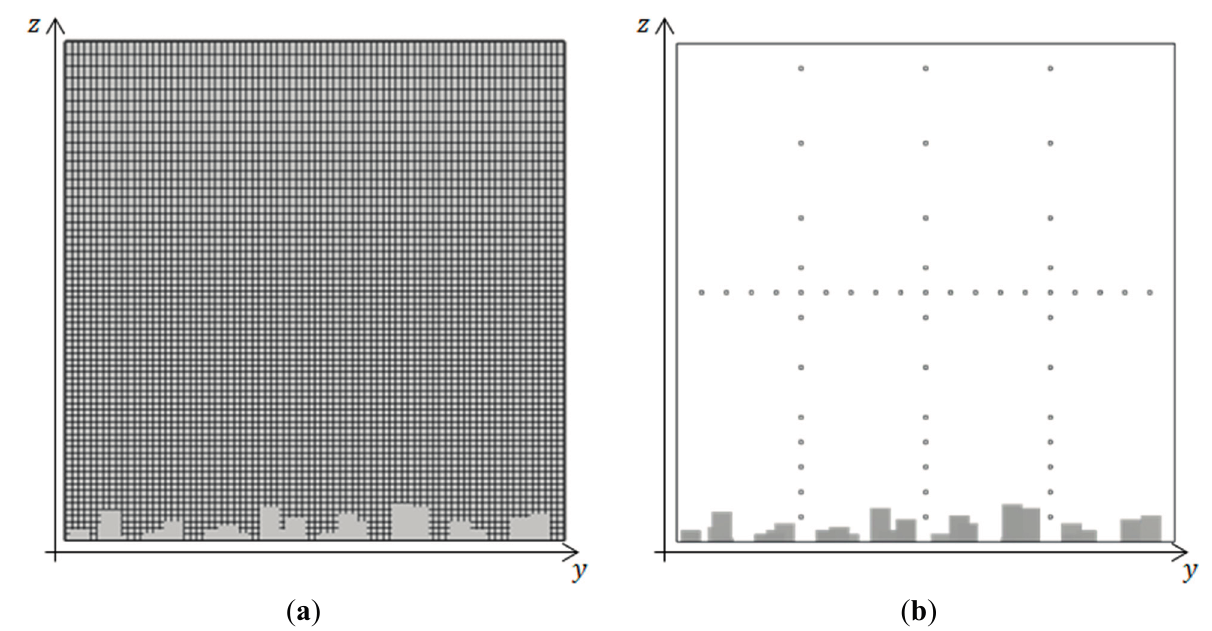
Figure 3. x -projection of computational domain. ( a ) Meshing and roughness cubes; ( b ) Probe